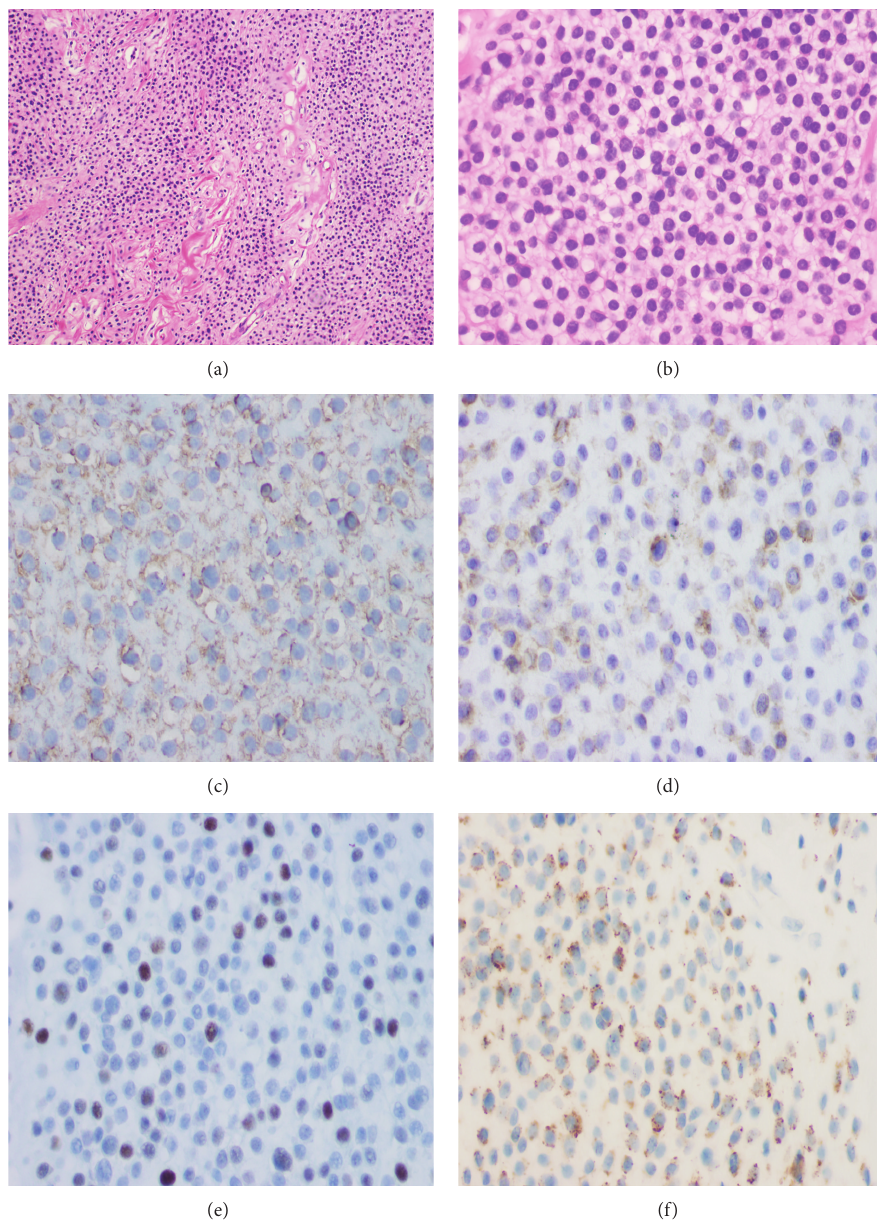
Figure 1: (a)Morphologic examination reveals interstitial lymphocytic infiltrateof small maturelymphocytes (H&E × 200). (b)Theneoplastic cells have round nuclear contours, condensed chromatin, inconspicuous nucleoli, and ample pale cytoplasm (H&E × 400). Immunohisto- chemical staining reveals that the neoplastic cells are CD20 positive B-cells (c) showing cytoplasmic staining for Annexin (d), nuclear staining for Cyclin D1 (e), and cytoplasmic TRAP (f). (Immunoperoxidase ×